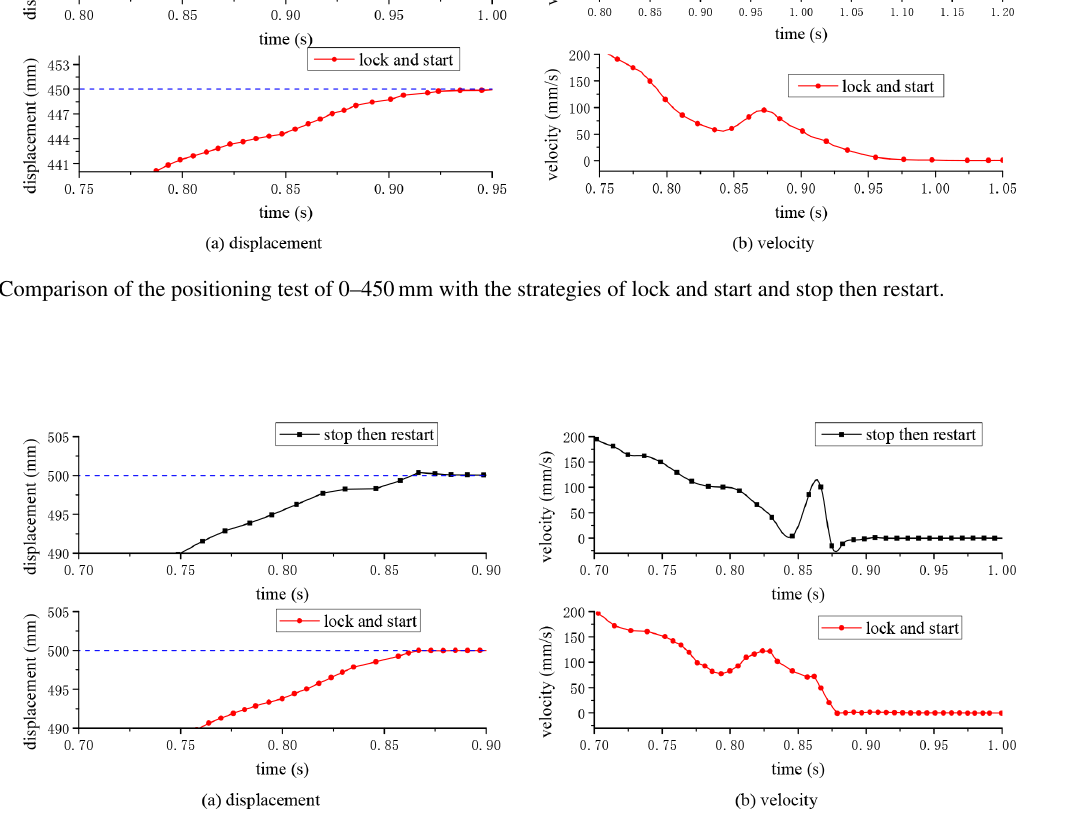
Mech. Sci., 12, 971–982, 2021